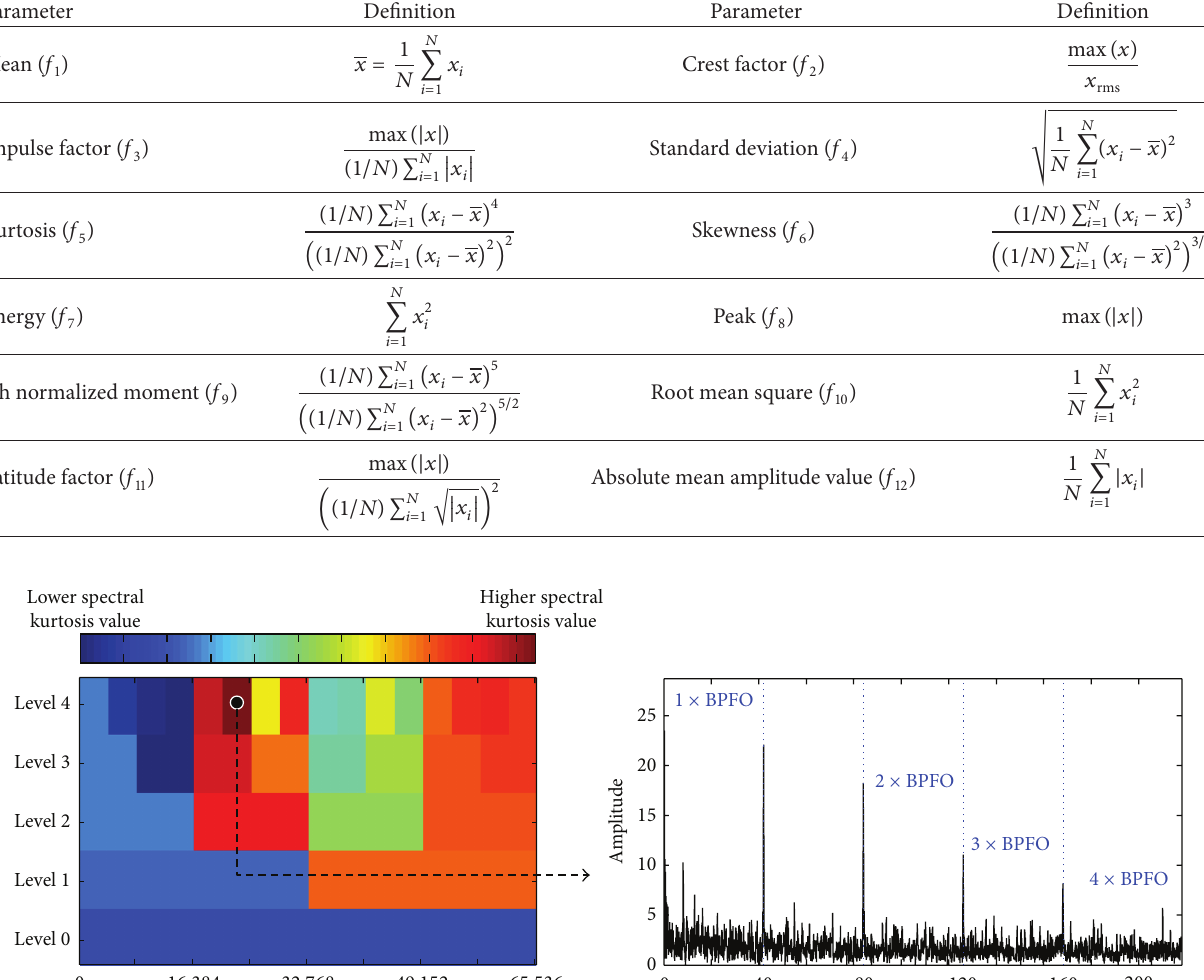
Table 3: Twelve statistical fault signatures, where 𝑥 is the most informative subband signal via spectral kurtosis analysis, 𝑁 is the total number is the root mean square value of 𝑥 , and max (|𝑥|) outputs the maximum value of 𝑥 . of the subband signal, 𝑥 rms